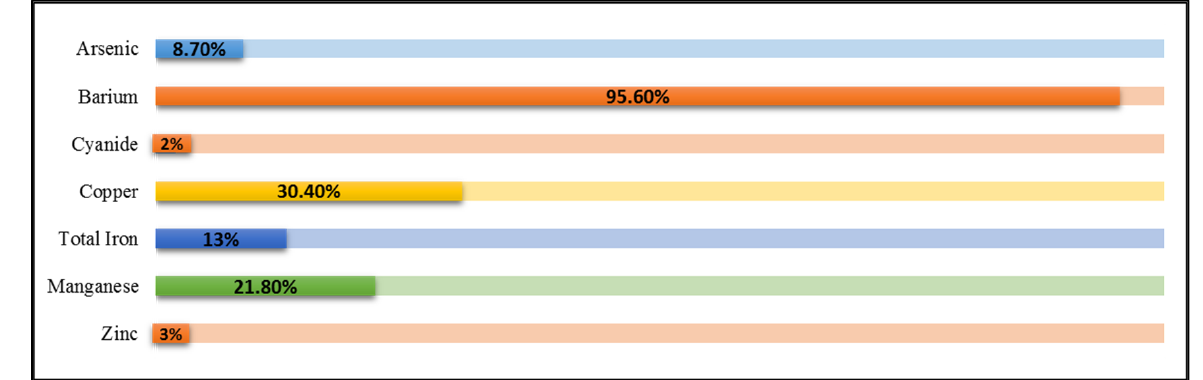
Table 5. General status of water samples and classification based on calculated WQI. Color coding reflects various WQI categories as noted in Table 2.